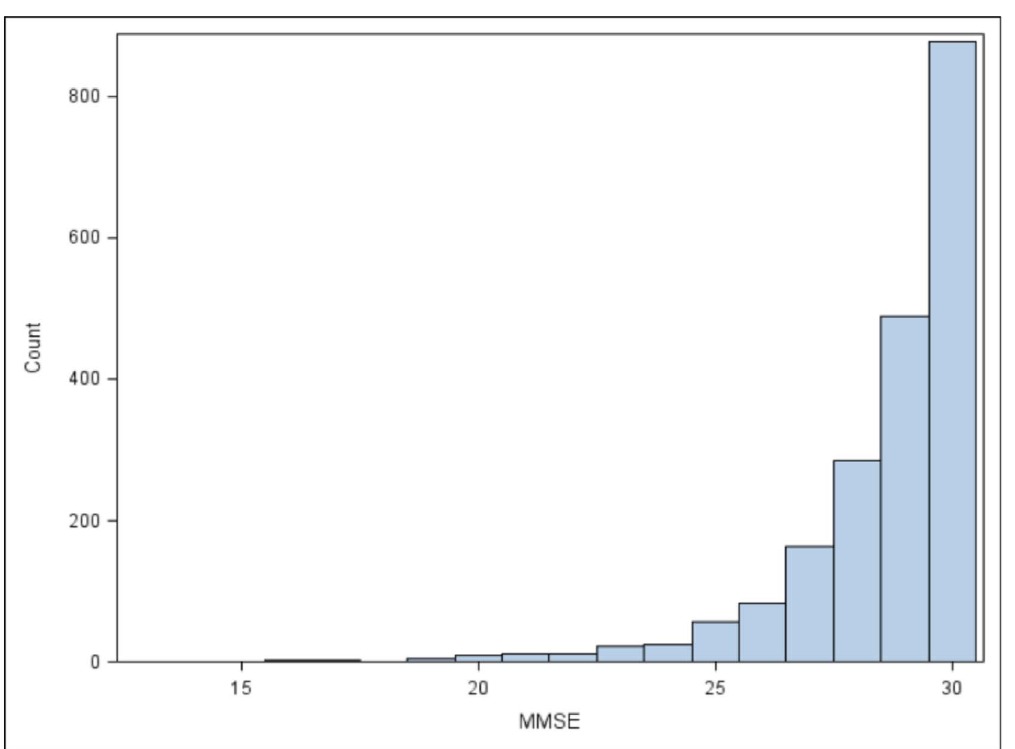
Figure 1. Distribution of the Mini-Mental Status Exam scores in WARCEF patients included for